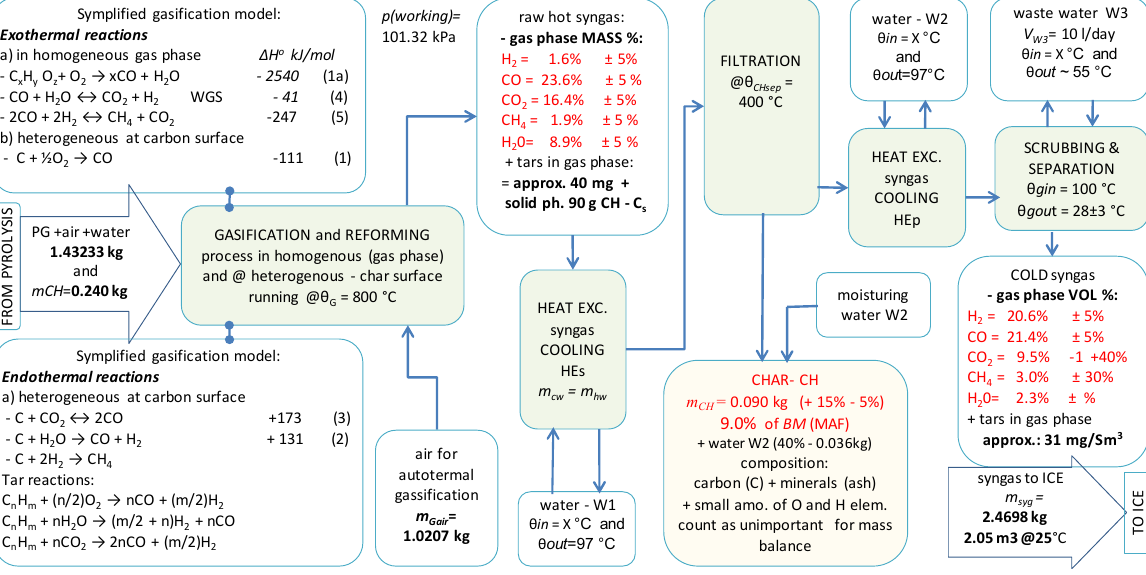
Figure 3. Block diagram of the CHPC process—part II gasification; mass balance, process parameters and streams in detail; unit mass case −1 kg of air-dry BM input.